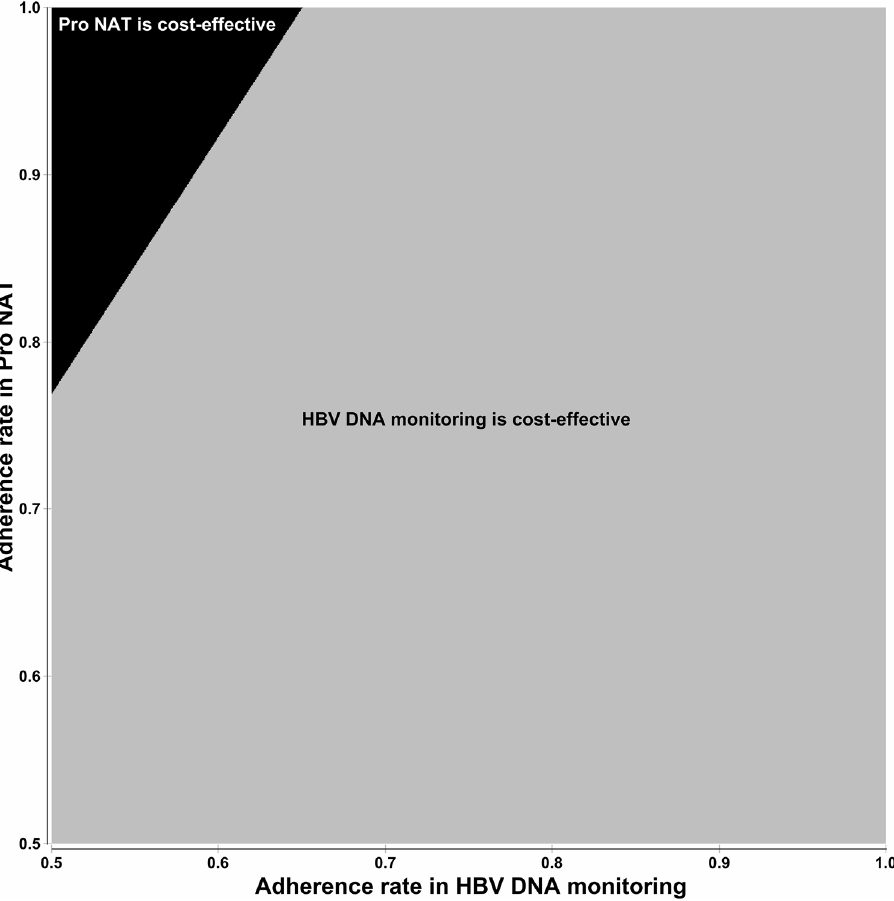
Figure 2. Result of the two-way sensitivity analysis. HBV DNA monitoring: HBV DNA monitoring followed by on-demand antiviral therapy; Pro NAT: Prophylactic anti-HBV nucleos(t)ide therapy The gray area indicates cases where HBV DNA monitoring strategy was more cost-effective than Pro NAT strategy. The black area indicates cases where Pro NAT strategy was more cost-effective than HBV DNA monitoring